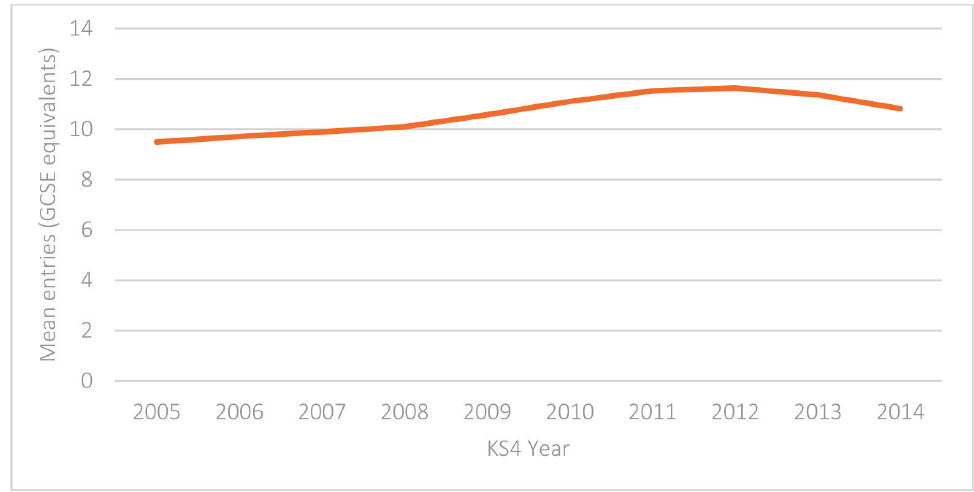
Figure 1: Mean number of qualifications entered (GCSE equivalents, old rules), pupils reaching the end of Key Stage 4 in maintained mainstream schools 2005 to 2014